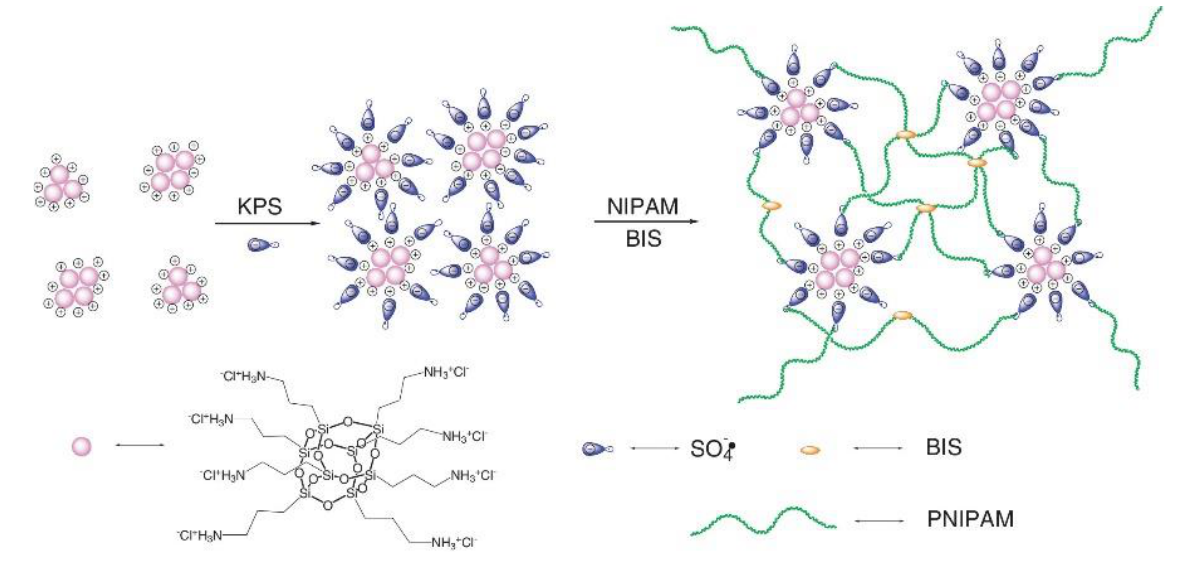
Figure 33. Formation of OCAPS-PNIPAM hydrogels. Copyright (2020) Wiley. Used with permission from Zhang, X.; Shen, W.; Dou, J.; Meng, Y.; Fang, S.; Liu, R., Enhanced mechanical properties and